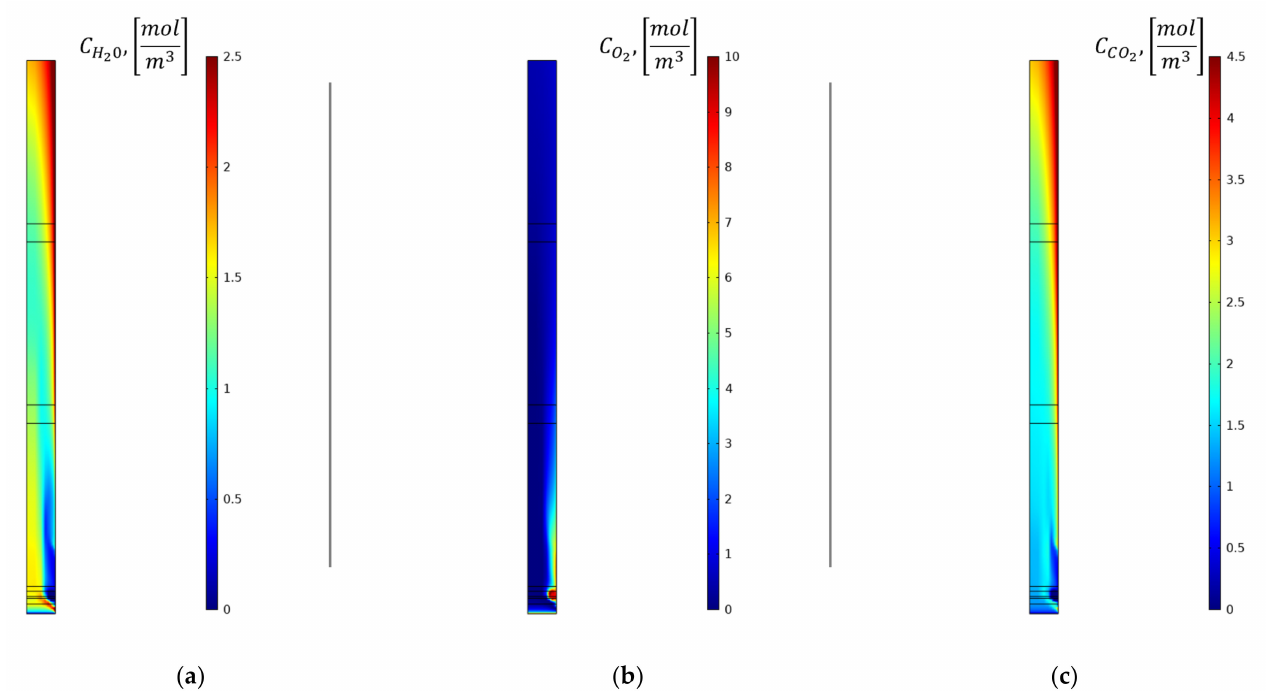
Figure 10. Distributions of fields when using raw straw pellets: concentration of ( a ) H 2 O, ( b ) O 2 , ( c ) CO 2 .